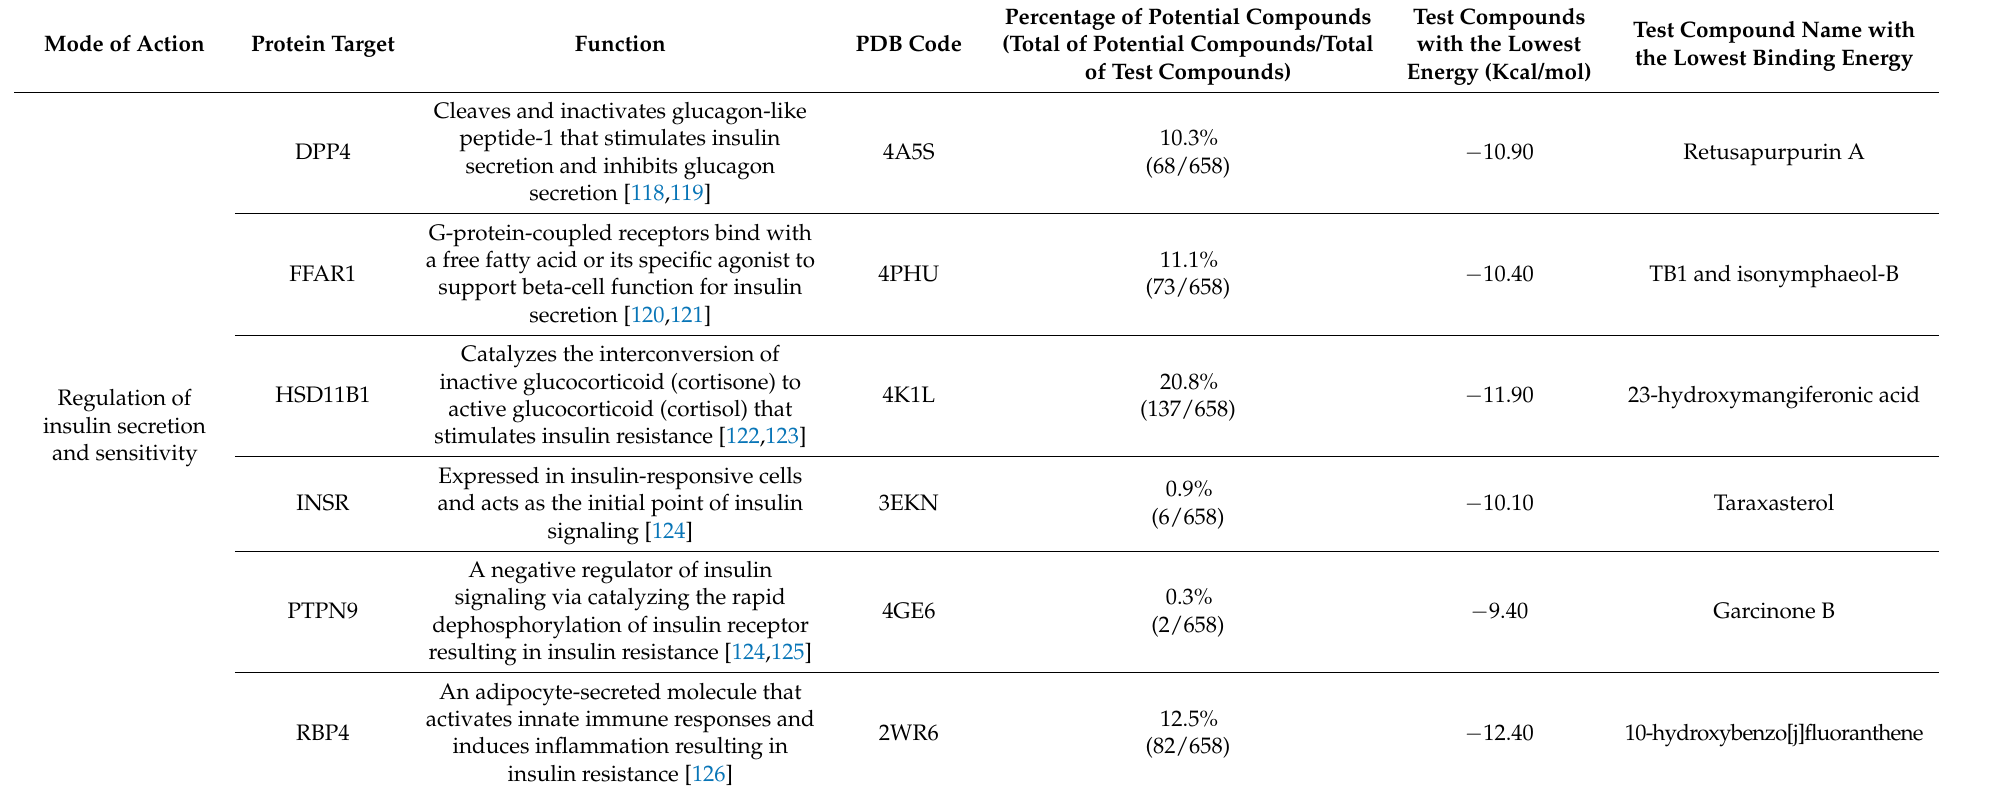
Table 1. Summary of inverse virtual screening of Asian propolis